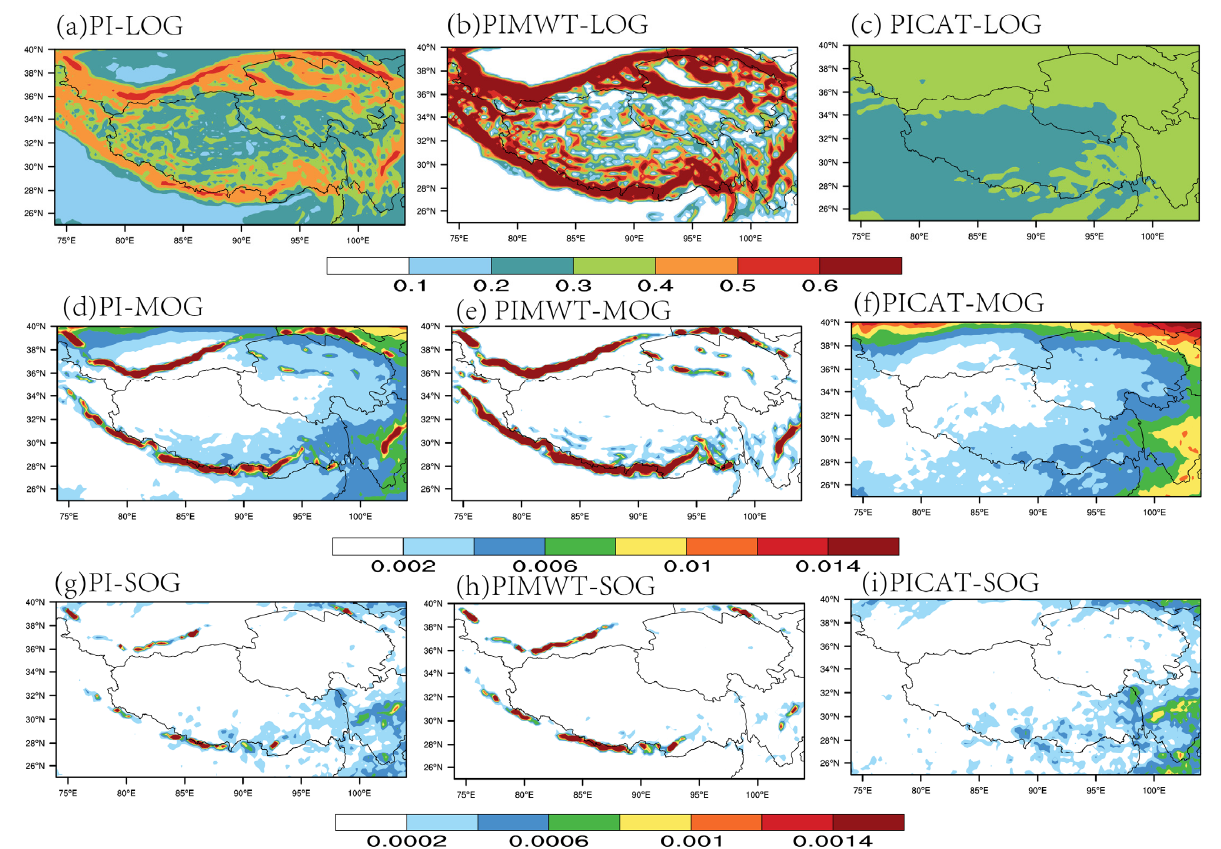
Figure 5. Averaged (left column) PI, (middle column) PIMWT, and (right column) PICAT over August 2012–2021 (31 × 10 × 8 = 2480 epochs in total) on 200 hPa for intensities of ( a – c ) light or greater, ( d – f ) moderate or greater, and ( g – i ) severe or greater. The characteristics of the turbulence probability index have been analyzed above.